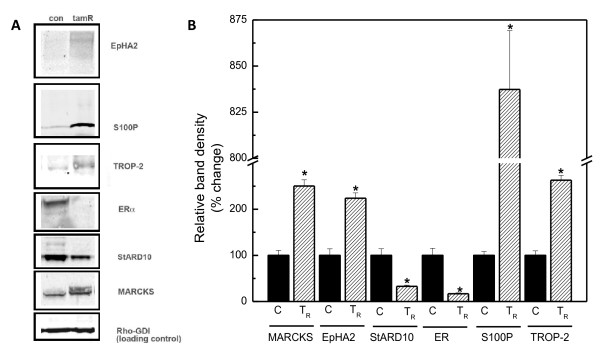
Western blot analysis confirms protein changes in MCF-7-TamR cells initially identified in quantitative proteomics. A) A representative Western blot of control (con) and tamoxifen resistant (MCF-7-TamR) cells showing the different expression levels of the indicated proteins. B) Four independent samples from each cell line were used to quantify the levels of each protein. The housekeeping protein Rho-GDI was used as an internal loading control. For comparative purposes, the control samples were set to 100%.